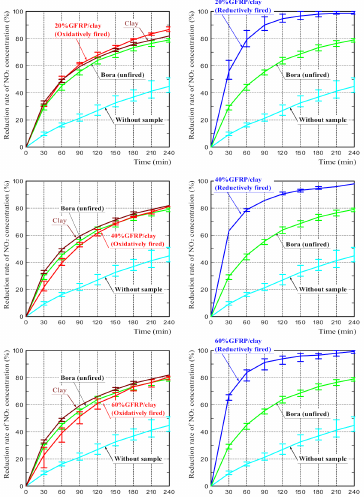
Figure 6. NO 2 reduction rates for the